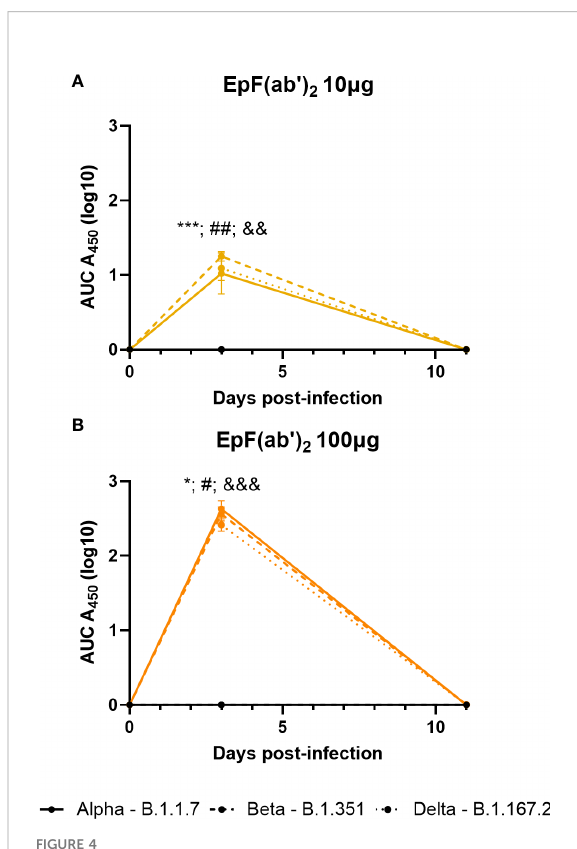
FIGURE 4 Kinetics of EpF(ab ’ ) 2 in serum after passive immunization in challenged K18-hACE2 mice. AUC representation of EpF(ab ’ ) 2 ELISA detection in the serum at days 3 and 11 in K18-hACE2 mice challenged with Alpha, Beta, and Delta, and passively immunized with either 10 m g (A) or 100 m g (B) of EpF(ab ’ ) 2 . Statistical analyses were performed as one-sample t -tests compared to the naïve animals (*p<0.05; ***p<0.001; # p<0.05; ## p<0.01; && p<0.01; and &&& p<0.001). Results from statistical analyses of comparisons of Alpha to naïve animals are represented with *, Beta to naïve animals with #, and Delta to naïve animals with